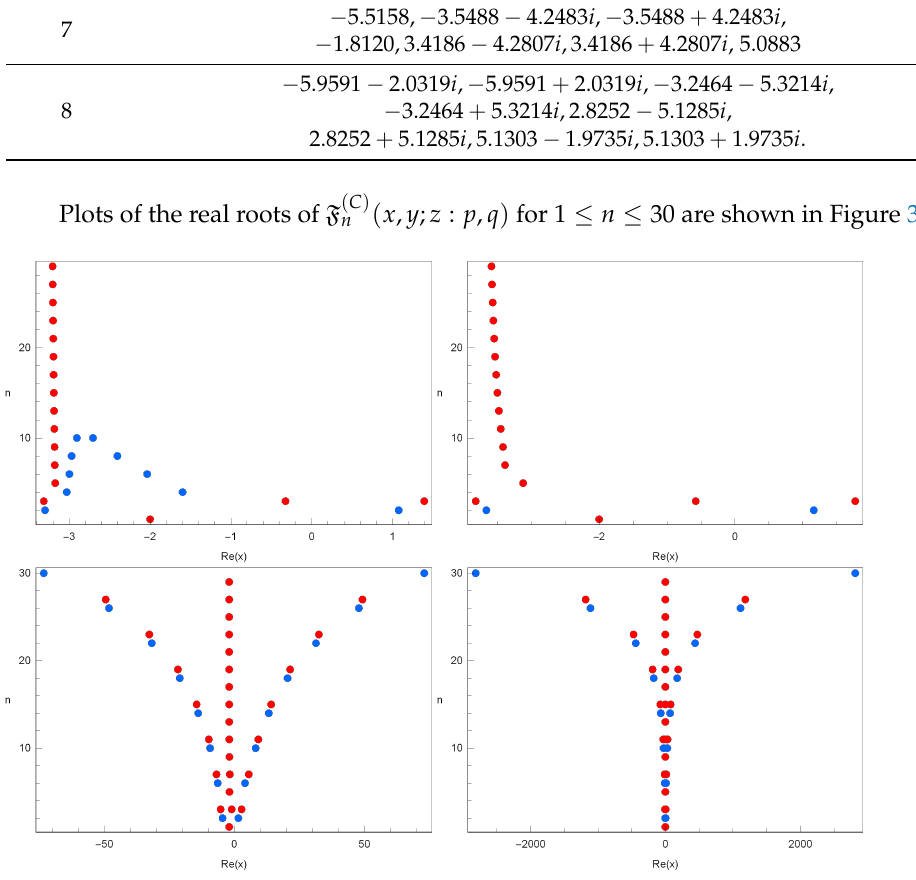
, 8 , 6 , 5 , q = 1 , 2 , 3 , 4 , y = 3 and z = 10 10 10 10 10 10 10 10